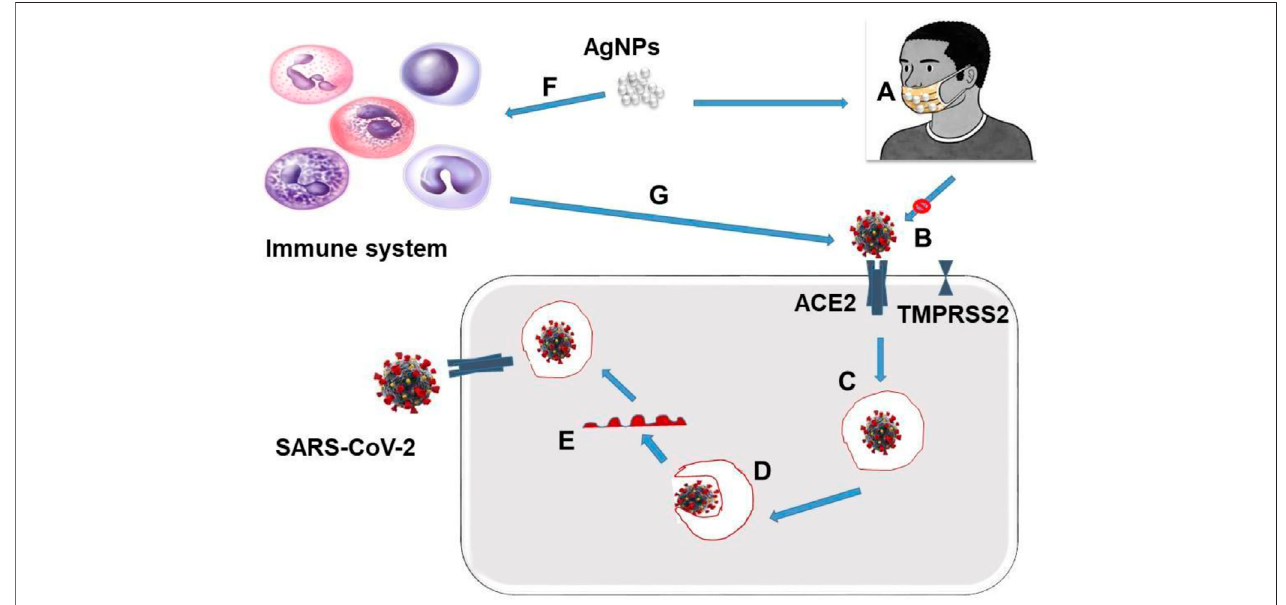
FIGURE 4 | Multiple pathways through with AgNPs mitigate COVID – 19 ‘ A ’ is the reusable facemask coated with Silver nanoparticles AgNPs ‘ B ’ Inhibition of COVID-19 ’ sSpikeproteinattachmentwithACE2receptors,preventingthecellularentrance. ‘ C ’ EscarpmentofCOVID-19fromtheendosome ‘ D ’ Membranefusionand uncoating ‘ E ’ release ofviralgenome ‘ F ’ Immunostimulation ‘ G ’ StrengthimmunesysteminhibitcellularentranceofSARS-CoV-2 bypreventingtheACE2receptorsand Spike protein